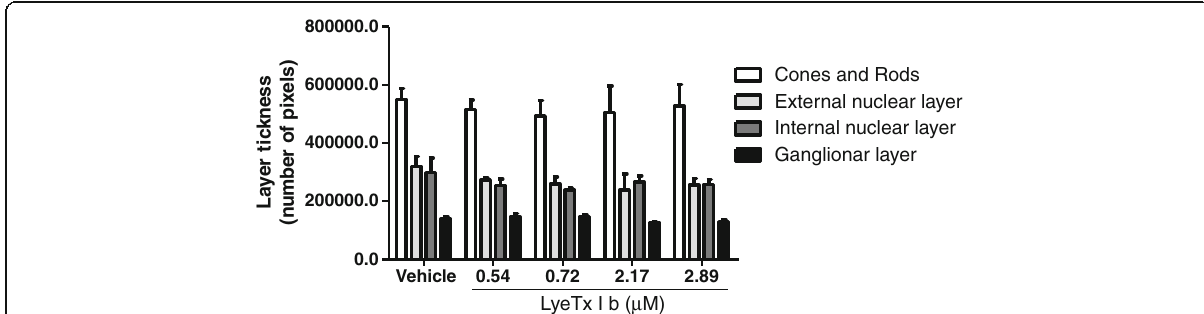
Fig. 9 LyeTx I b does not alter the morphological integrity of the retina: Graph shows the measure of layer thickness of cones and rods, external, internal and ganglion layers 28 days after intravitreal injection of Vehicle, LyeTx I b 0.54 μ M, LyeTx I b 0.72 μ M, LyeTx I b 2.17 μ M or LyeTx I b 2.89 μ M. Data represent the means ± SEM of three independent experiments. No significant difference was observed as compared to vehicle group (p > 0.05). Abbreviations: SEM, standard error of the mean